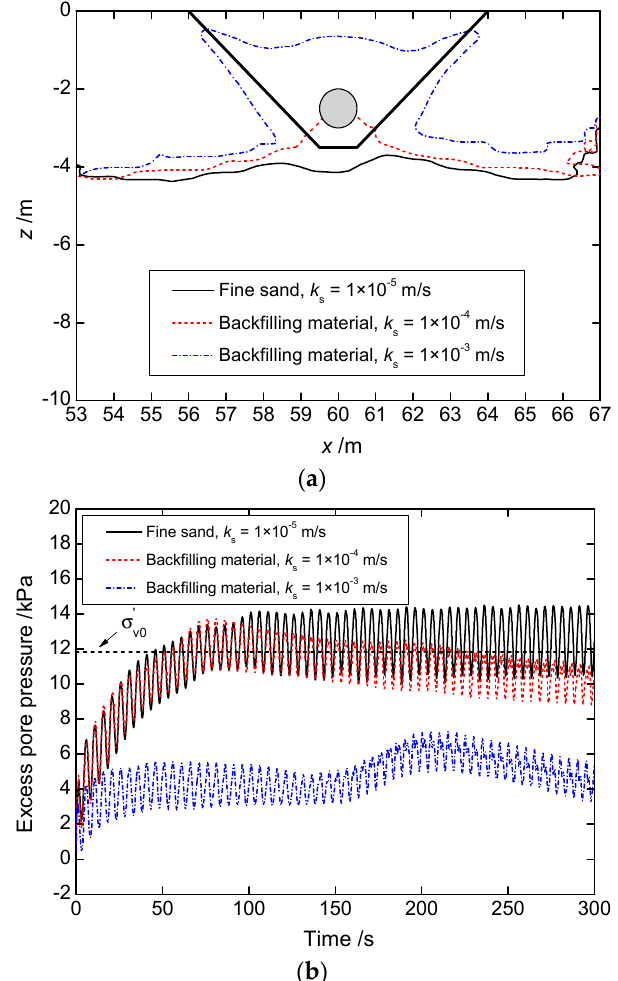
Figure 8. Response of seabed with a trench layer: ( a ) liquefaction zone; ( b ) time traces of excess pore pressure at point A.